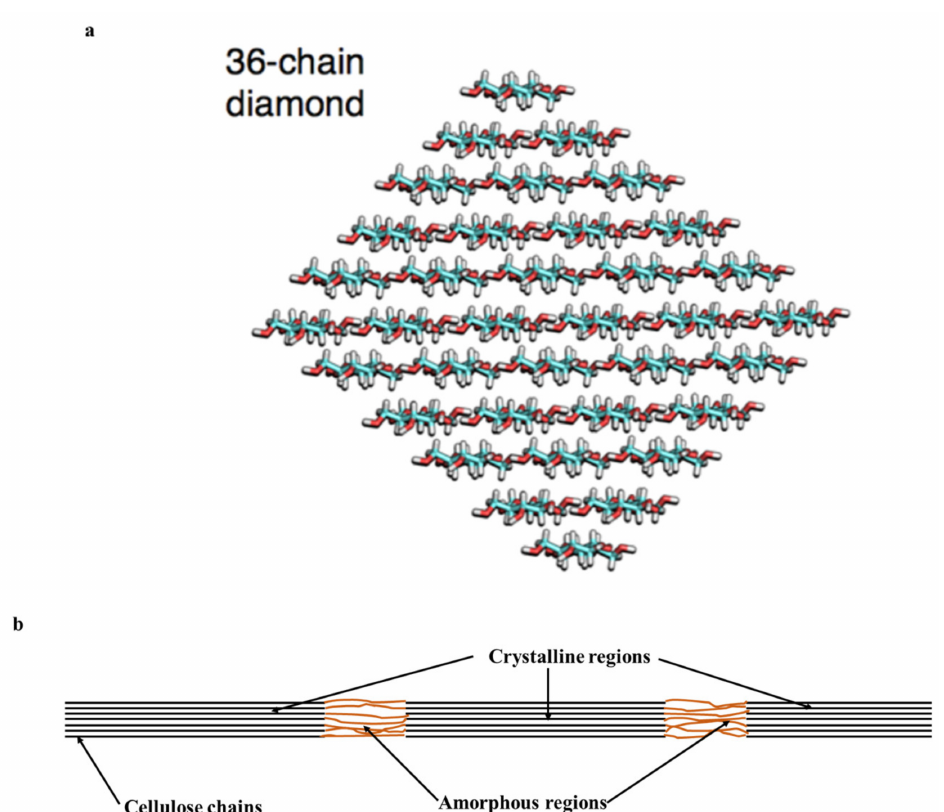
Figure 2. Organization of cellulose: ( a ) prevailing 36-chain model of cellulose elementary fibril. Adapted with permission from [30], © 2021 American Chemical Society; ( b ) schematic representation of cellulose microfibril showing crystalline and amorphous